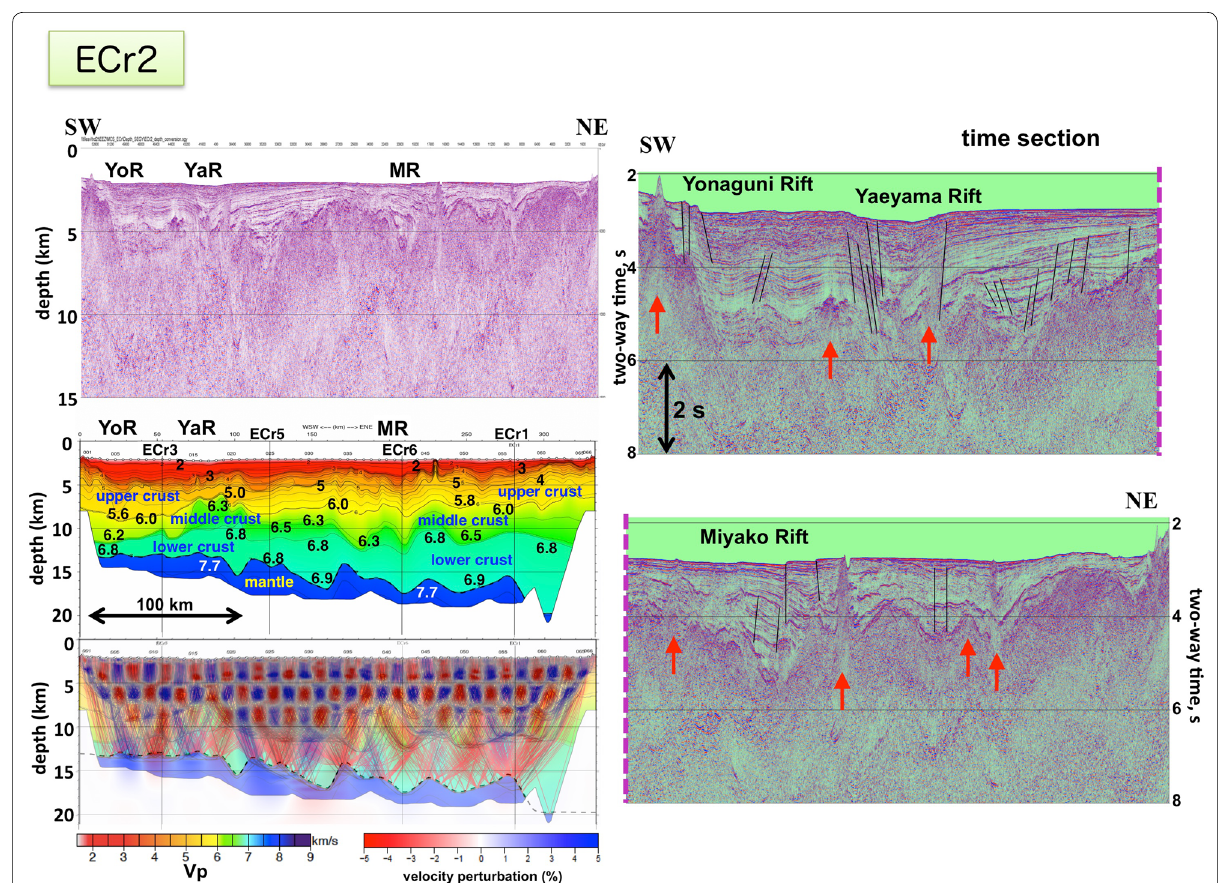
Fig. 14 MCS depth section (top left), V p model (middle left), and checkerboard test result with ray coverage (bottom left) for ECr2. The ray paths correspond to manual readings on the observed record sections. The enlarged time sections are divided into two parts and displayed on the right. The black lines in the time sections indicate steeply dipping normal faults. YoR Yonaguni Rift, YaR Yaeyama Rift, MR Miyako